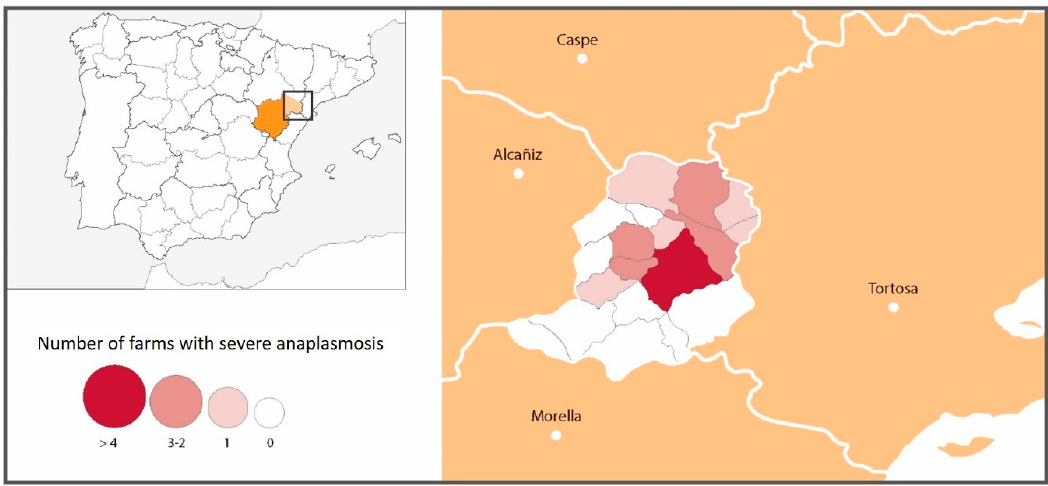
Figure 3. Number and location of farms with severe anaplasmosis.